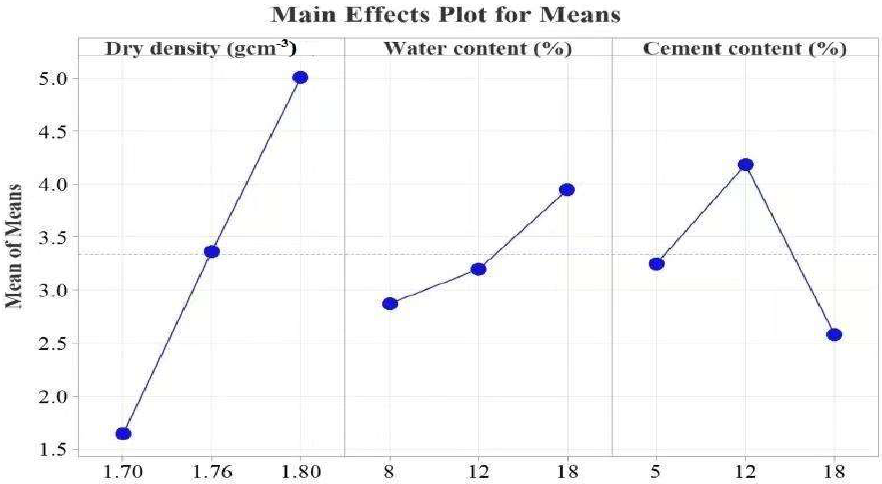
Figure 9. Effects of the control factors on USC.